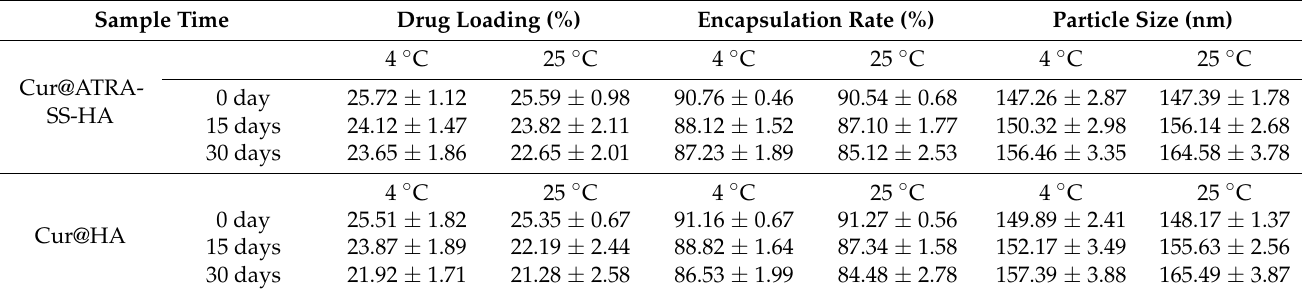
Table 2. Stability of Cur@ATRA-SS-HA and Cur@